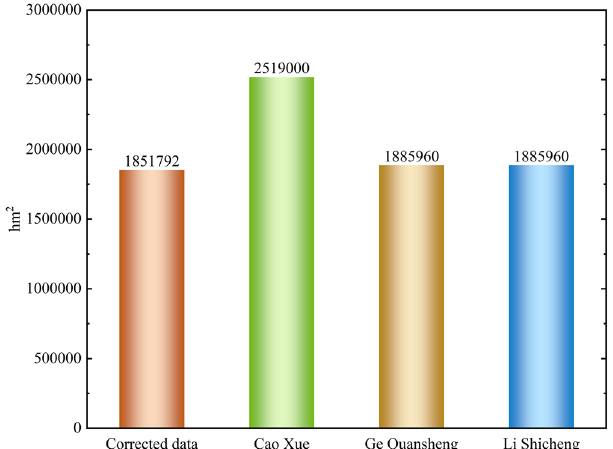
Figure 3. Comparison of cropland area correction.